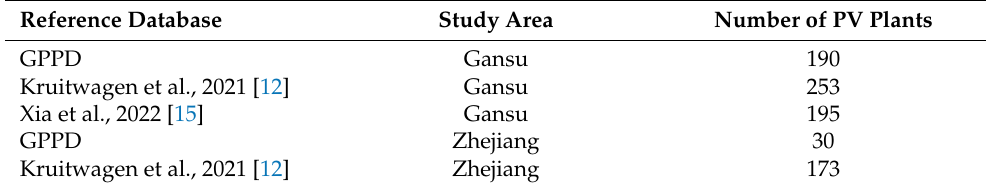
Table 1. Number of PV installations in existing published PV